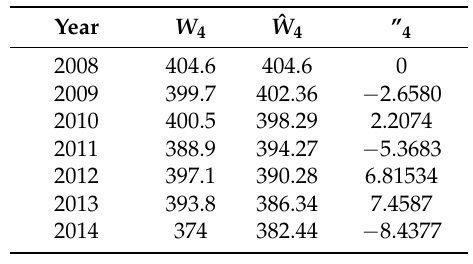
Table 6. Simulation results of W 4